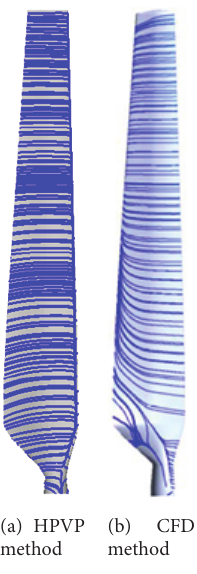
Figure 5: Blade suction surface limit streamline comparison in dif- ferent